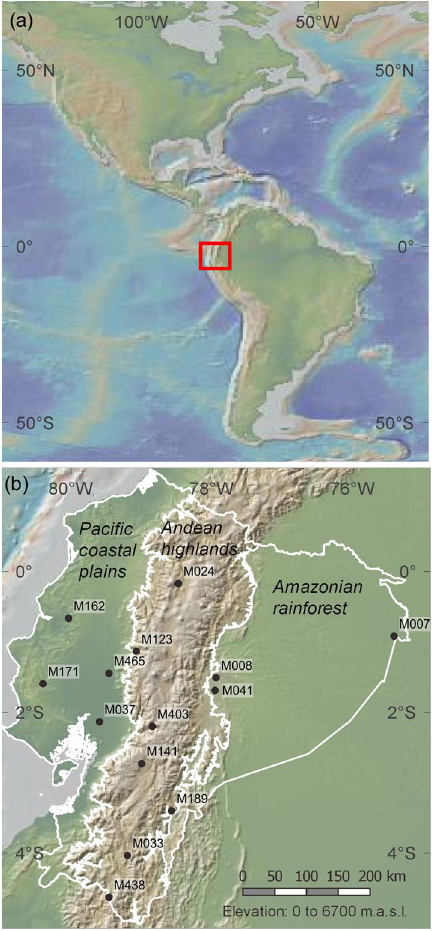
Figure 1. Study area. (a) Ecuador in the American Continent context; (b) Three main regions of study and rain gauges